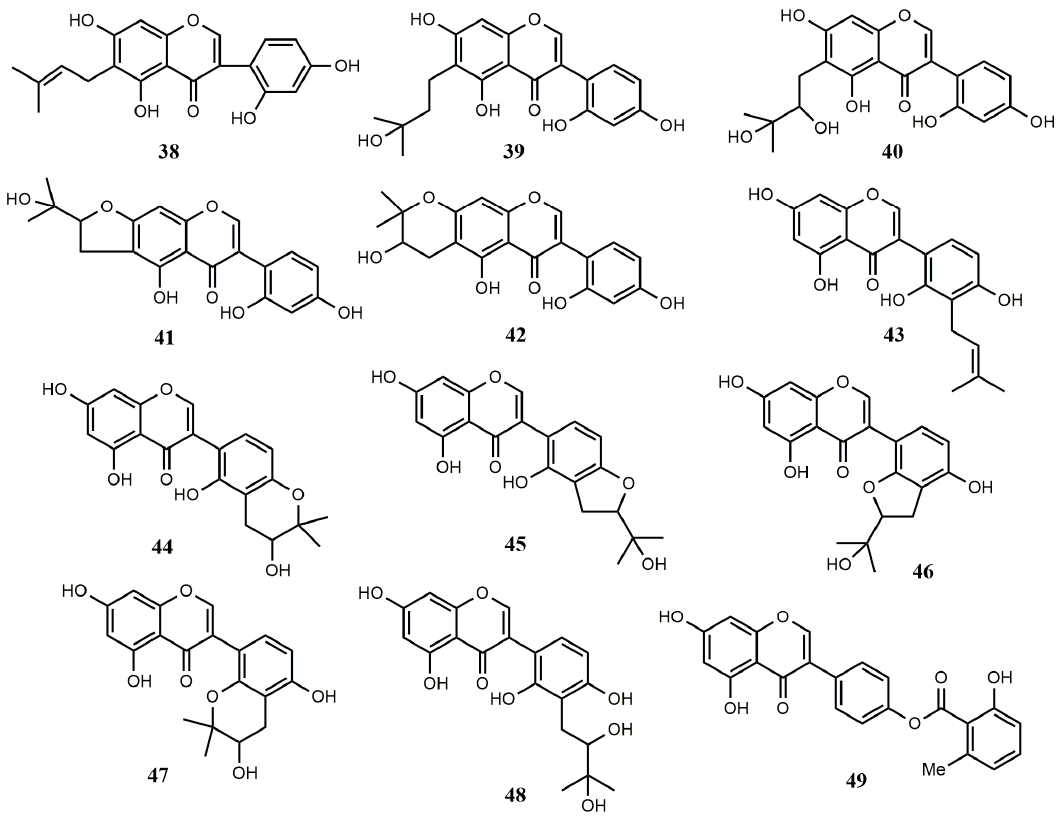
Figure 3. Reported structures of complex isoflavones 38 – 49 from fungi and actinomycetes.